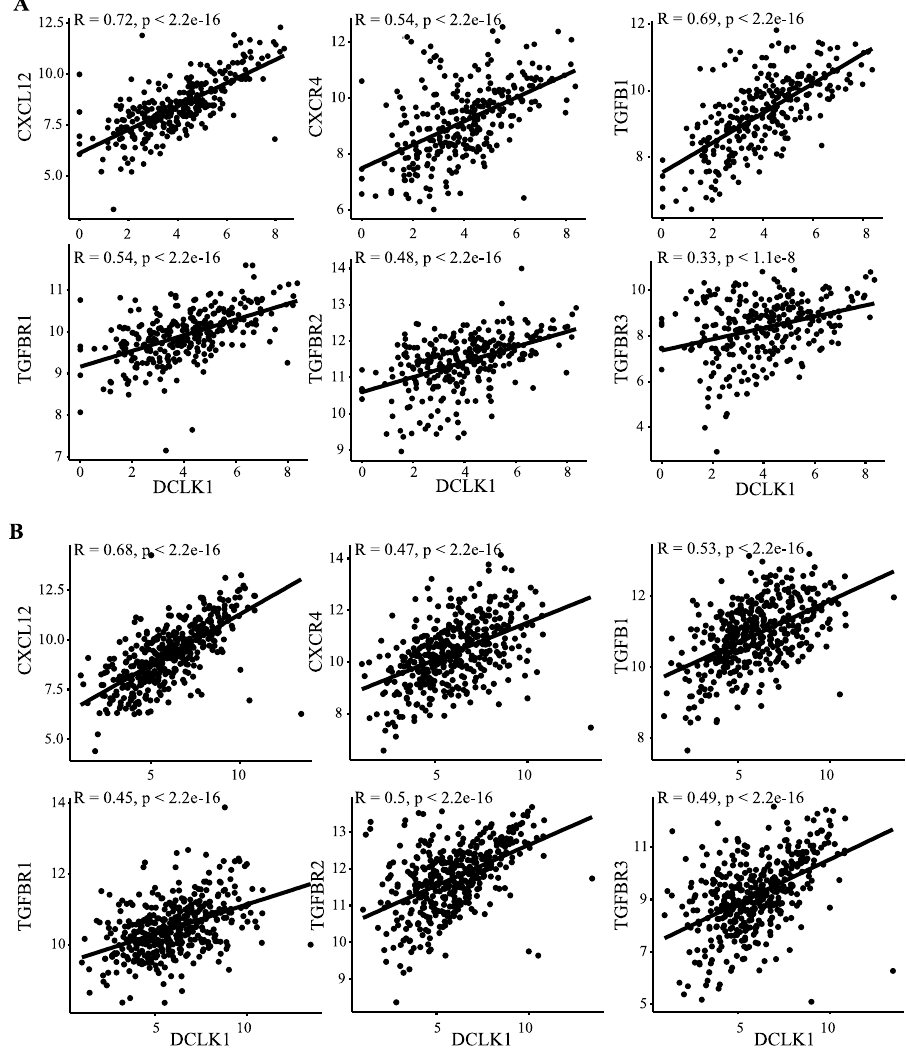
Figure 5. DCLK1 expression is positively associated with CD8 + T cell inhibitors induced by TAMs. Correlation analysis suggests that DCLK1 expression is significantly positively correlated with TGF-B1 and CXCL12 and their specific receptors TGF-BR1, TGF-BR2, and TGF-BR3, and CXCR4, respectively, in COAD ( A ) and STAD ( B ).